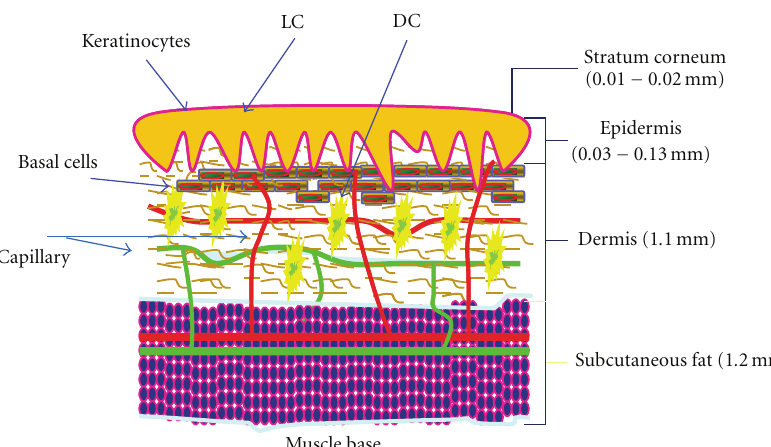
Figure 1: A schematic diagram of the skin . A cartoon drawing based upon the textbook descriptions of the thickness of outer skin layers. Only layers relevant to the subject are shown. LC, Langerhans cells; DC, dendritic cells; Capillary, green and red